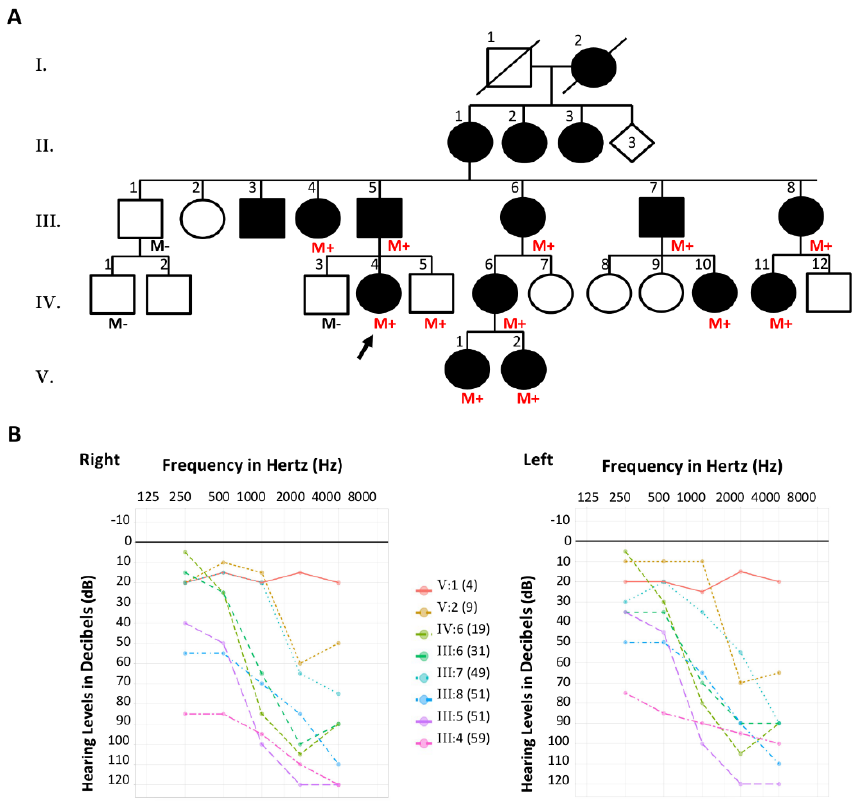
Figure 1. Family S2426. ( A ) Pedigree of the family. Filled symbols denote affected individuals. The proband referred for molecular testing is indicated by a black arrow. M+ (red font): presence of the GSDME deletion, M − (black font): absence of the GSDME deletion. ( B ) Superimposed pure-tone audiograms of eight affected individuals. The numbers in parentheses indicate the subject’s age at the audiometric testing. Left chart: right ear, right chart: left ear.